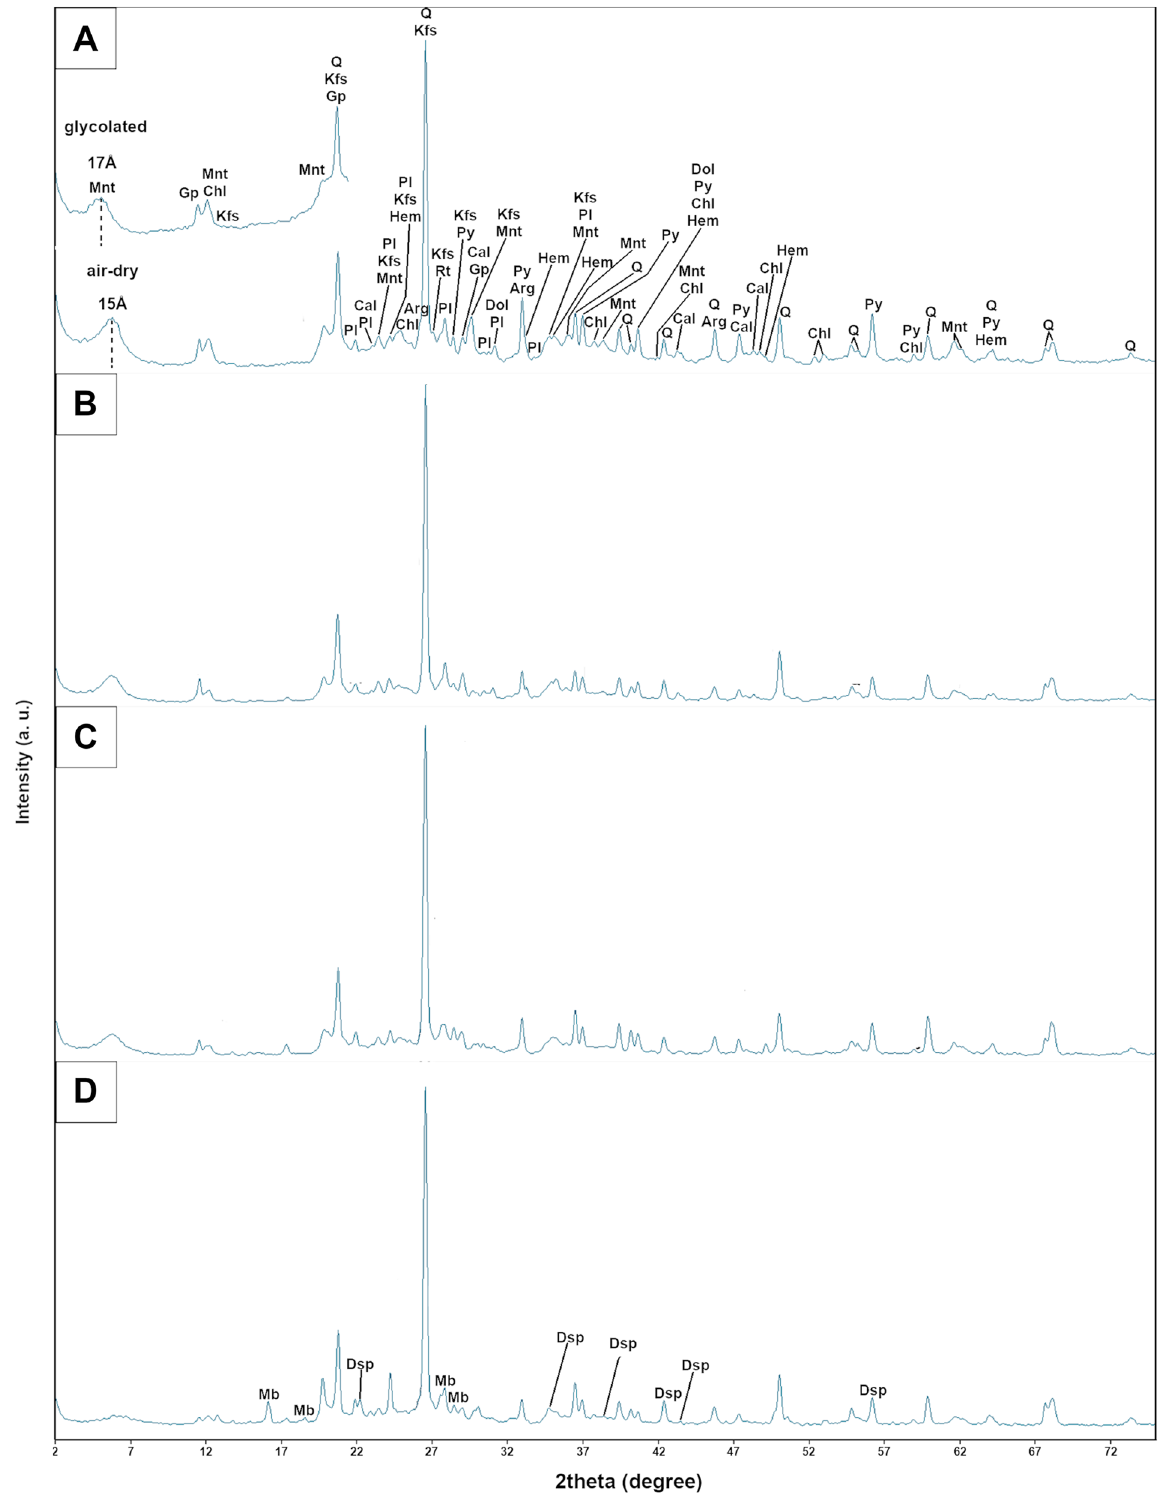
Figure 5. X-ray diffraction of studied rocks: ( A ) reflections from glycolated saturation and from air-dry preparations (SC1); ( B ) SC2, ( C ) SC3, ( D ) SC4. Symbols: Arg—aragonite; Cal—calcite; Chl—chlorite; Dol— dolomite; Dsp—diaspore; Gp—gypsum; Hem—hematite; Kfs—K feldspar (microcline, orthoclase); Mb— mirabilite; Mnt—montmorillonite; Pl—plagioclase; Py—pyrite; Q—quartz;